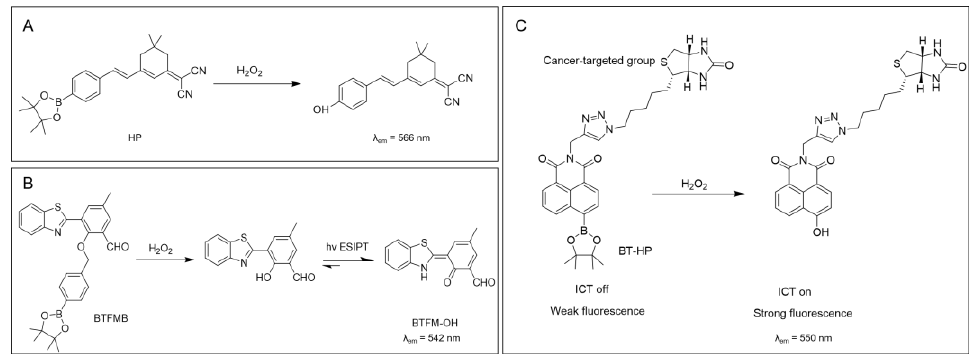
Figure 10. The response mechanism of ( A ) HP [62], ( B ) BTFMB [65] and ( C ) BT − HP [66] with H 2 O 2